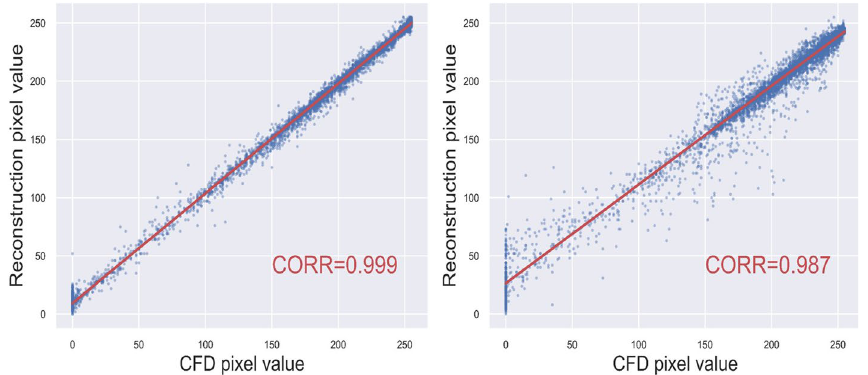
Fig. 10 All pixel scatter plots and correlation coefficients of flow field reconstruction